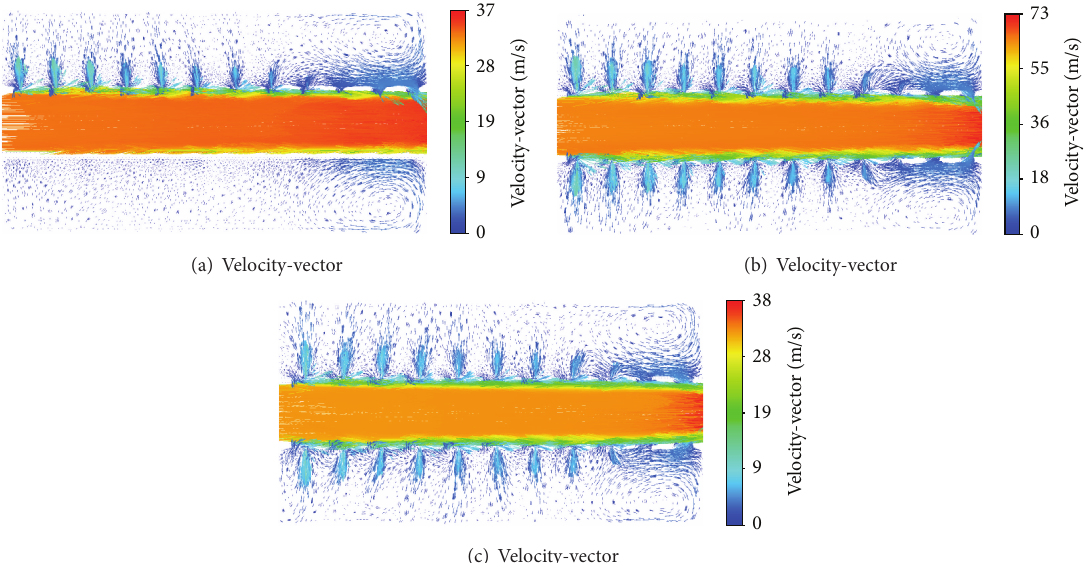
Figure 7: Velocity-vectors for the straight-through perforated pipe silencers: (a) silencer 𝑃 1 , 𝑀 = 0.1 , (b) silencer 𝑃 2 , 𝑀 = 0.2 , and (c) silencer 𝑀 = 0.1 . 𝑃 3 ,